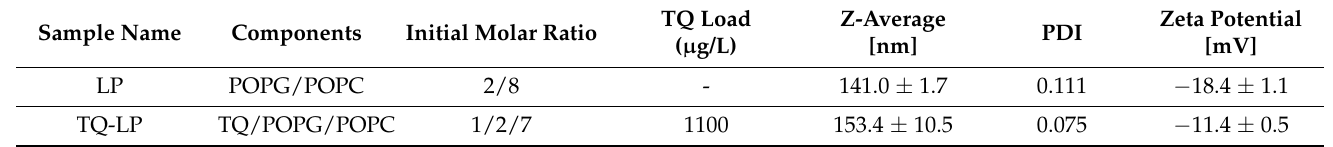
Table 1. Studied liposome samples and their composition and characterized parameters: